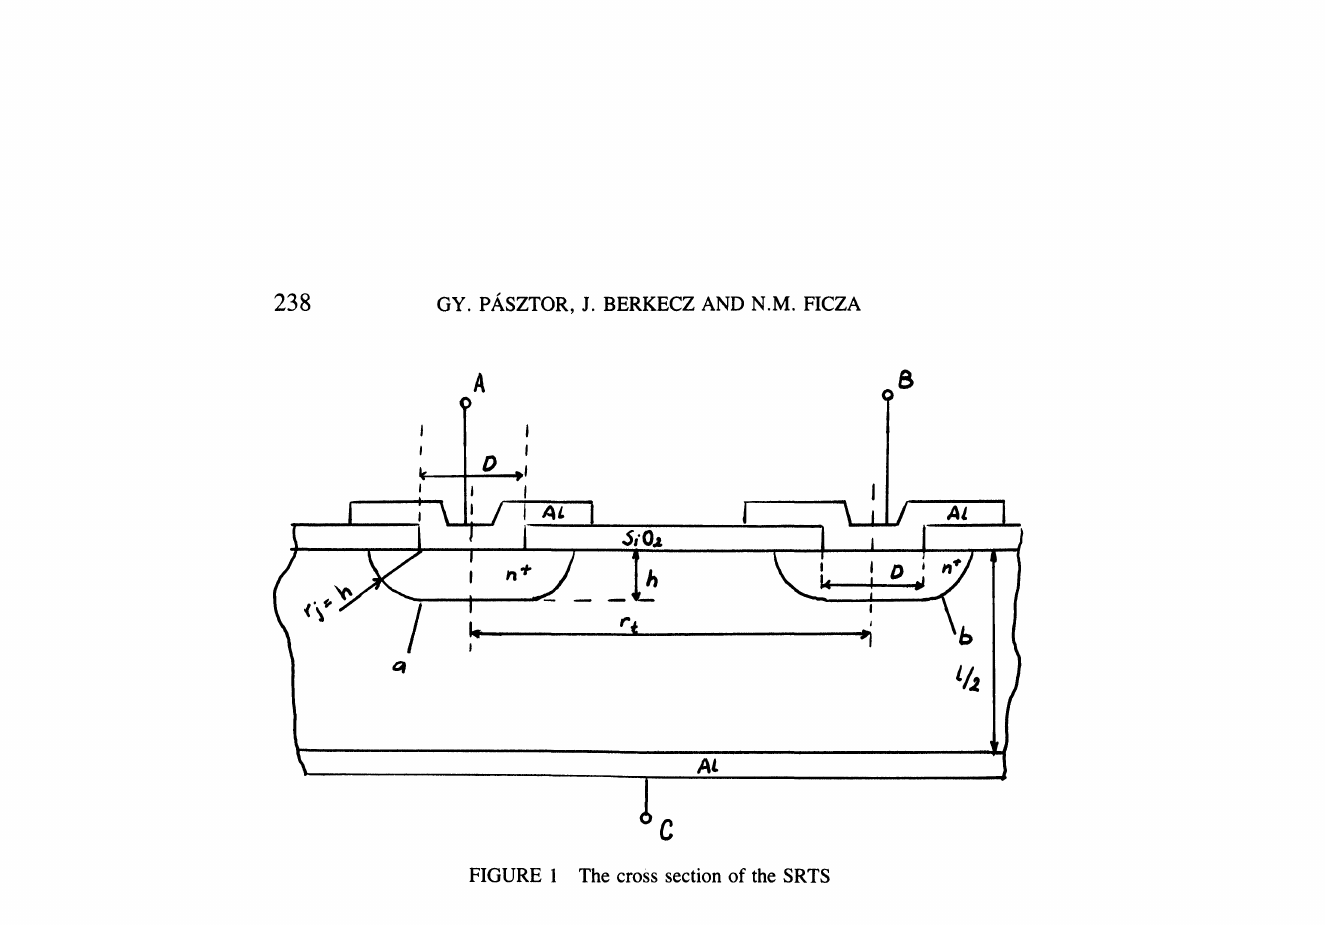
FIGURE The cross section of the